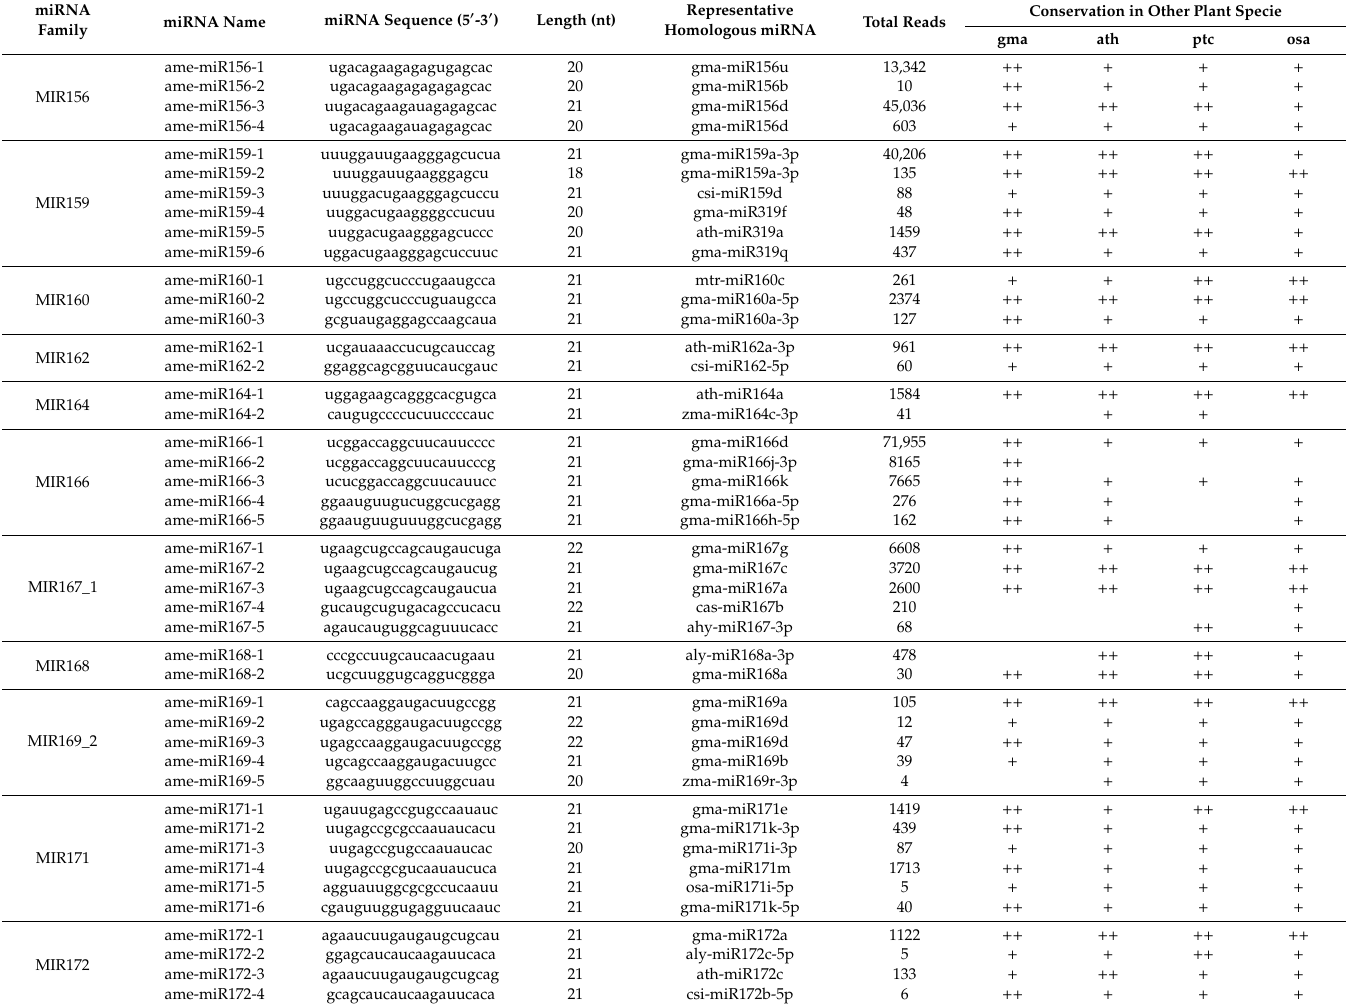
Table 2. Predicted conserved miRNAs with identified precursors from A.